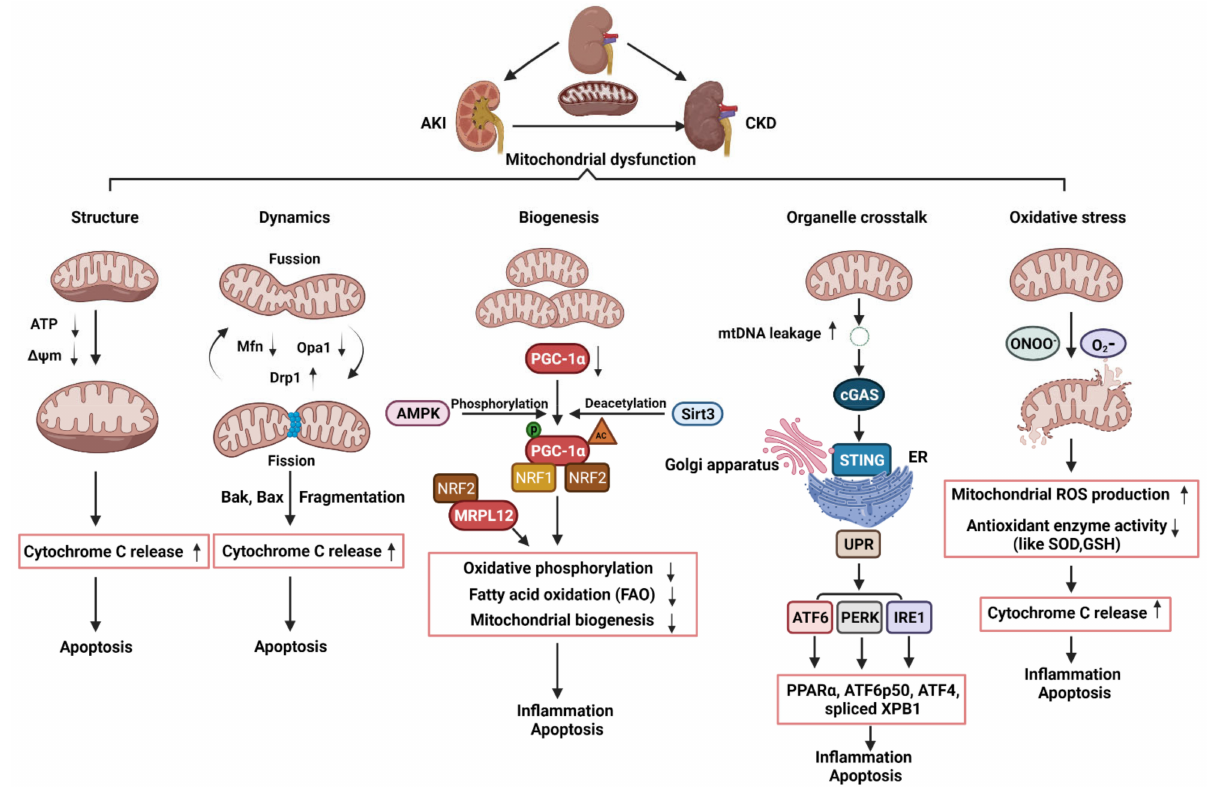
Figure 2. Schematic illustration of pathophysiological processes of mitochondrial dysfunction, including alterations of mitochondrial structure, dynamics, biogenesis, organelle crosstalk, and oxidative stress, in the AKI, CKD, and AKI to CKD transition. AKI: acute kidney injury; CKD: chronic kidney disease; ATP: adenosine triphosphate; ∆Ψ m: mitochondrial membrane potential; Mfn1: mitofusin 1; Opa1: optic atrophy 1; Drp1: dynamin related protein 1; mtDNA: mitochondria DNA; AMPK: AMP-activated protein kinase; PGC-1 α : PPARgamma-coactivator-1 α ; Sirt3: sirtuin 3; NRF1: nuclear respiratory factor 1; NRF2: nuclear respiratory factor 2; MRPL12: mitochondrial ribosomal protein L12; cGAS; cyclic guanosine monophosphate–adenosine monophosphate (GMP–AMP) synthase; STING: stimulator of interferon genes; ER: endoplasmic reticulum; UPR: unfolded protein response; PPAR α : peroxisome proliferator–activated receptor- α ; IRE1: inositol-requiring enzyme 1; PERK: PRKR-like ER kinase; ATF6 α activating transcription factor 6 α ; XPB1: the X-box binding protein 1; eIF2 α : eukaryotic initiation factor 2 α ; ATF4: activating transcription factor 4; ONOO-: